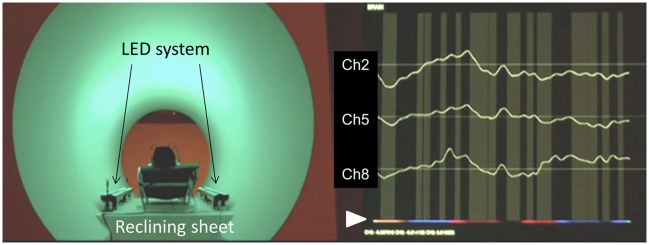
Example of the experiments: Left, subject reclines in the cylindrical tube stage (540 cm in length and 180 cm in diameter), and is equipped with the NIRS probes and headphones. The LED system provided a whole-body illuminating light source to the cylindrical surface, and the reconstructed waterfall sound was administered through the headphones. Right, changes in oxy-Hb at Ch 2, Ch 5, and Ch 8 were continuously monitored every 3 s. The arrowhead at the bottom shows the stimulus light generated by the LED system through the feedback algorithm. The vertical gray streak denotes decreases in oxy-Hb at Ch 5. Actual changes in signals and stimuli are shown in the Supplemental Video file.